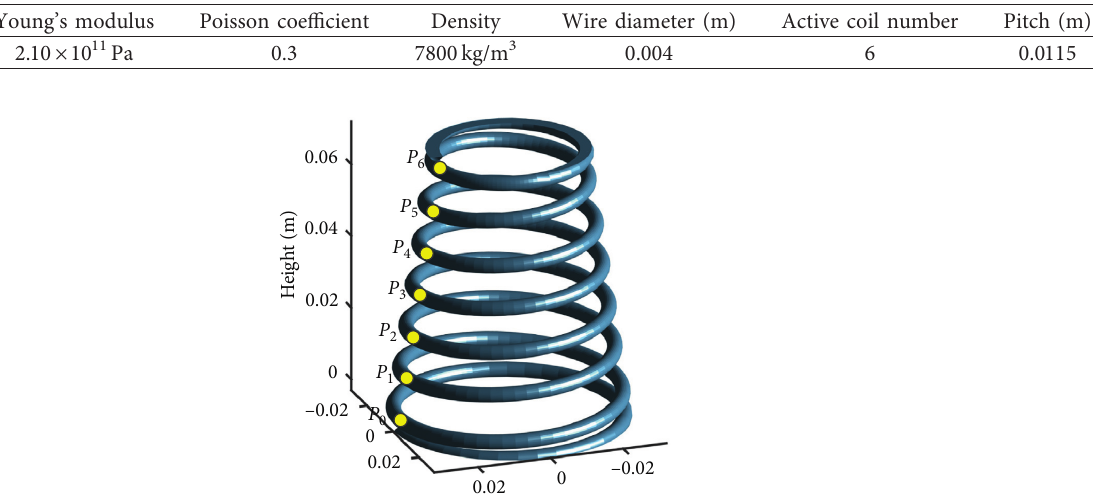
Table 7: Geometrical properties and material properties of the variable pitch spring.